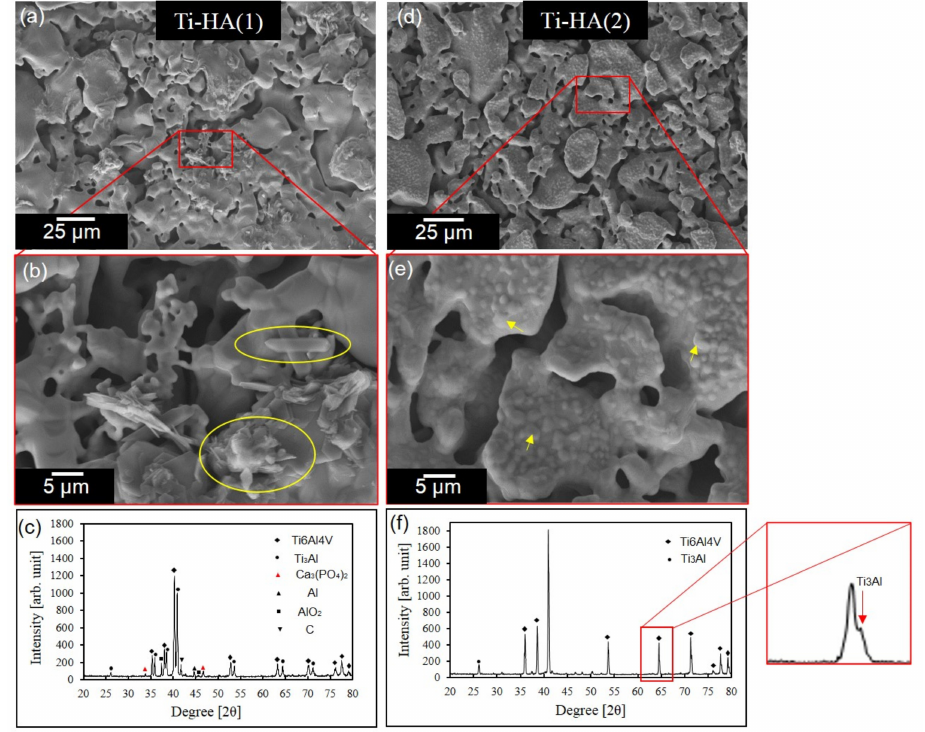
Figure 4. ( a , b ) SEM image of Ti-HA(1), ( c ) XRD pattern of Ti-HA(1), ( d , e ) SEM image of Ti-HA(2) and ( f ) XRD pattern